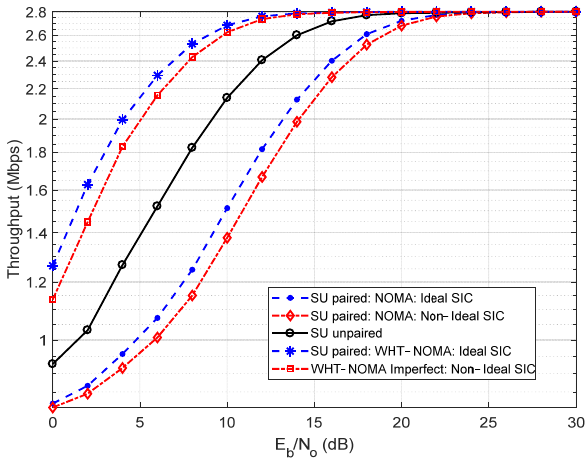
Figure 10. Throughput performance using BPSK modulation; NOMA vs. WHT–NOMA, power allocation: SU (SCU) = 0.4 and MU (SEU) = 0.6.